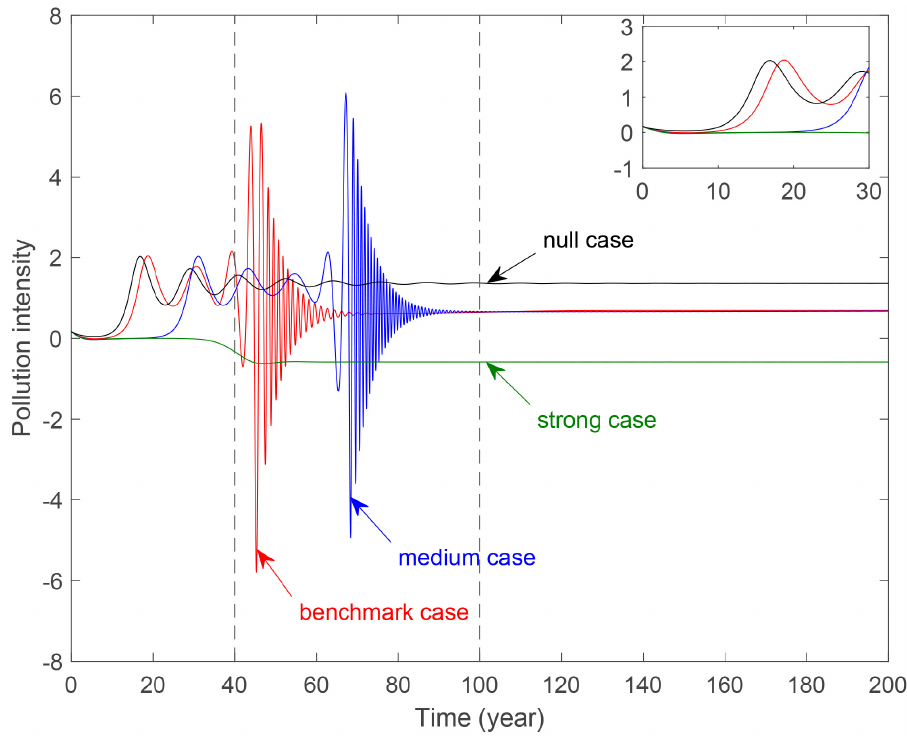
Fig 10. Evolution of pollution intensity with different government control parameter b 4 . Benchmark case : b 4 = 0.2488. Medium case : b 4 = 0.6488. Strong case : b 4 = 0.7488.